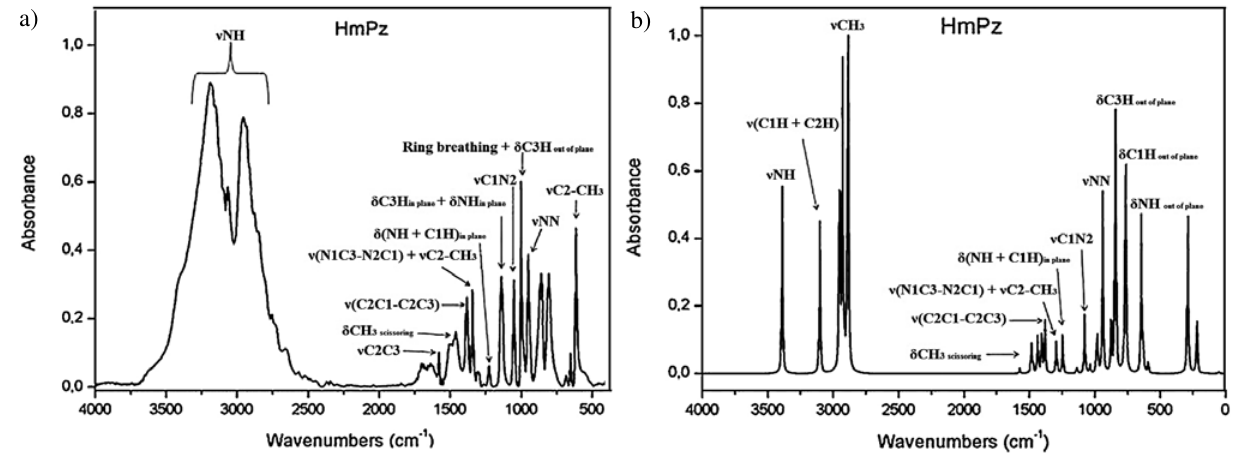
Figure 2. Experimental (a) and theoretical (b) IR spectra of the HmPz.